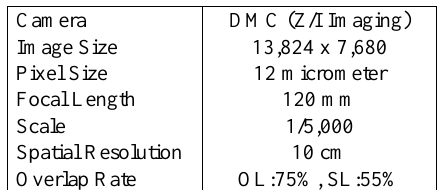
Figure 8. Estimation UI of Tree Density